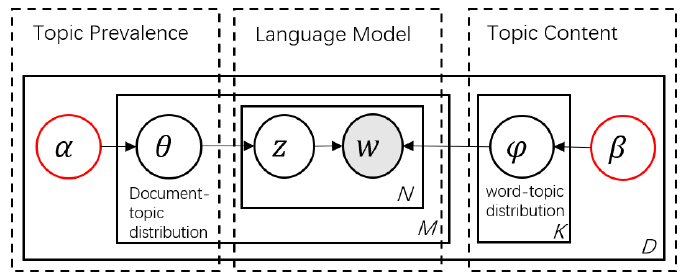
Figure 1. Plate diagram of Latent Dirichlet Allocation (LDA).